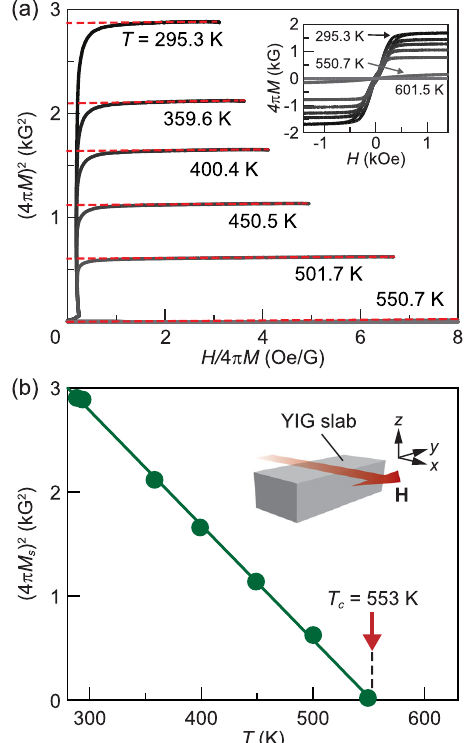
FIG. 4. (a) Arrott plots of the YIG slab for various values of T . The inset of (a) shows the H dependence of 4 π M of the YIG slab for various values of T , measured with a vibrating sample magnetometer. The lengths along the x , y , and z directions of the YIG slab used for the magnetometry measurements are 3, 7, and 1 mm, respectively. H is applied along the x direction. (b) T dependence of ð 4 π M s Þ 2 of the YIG